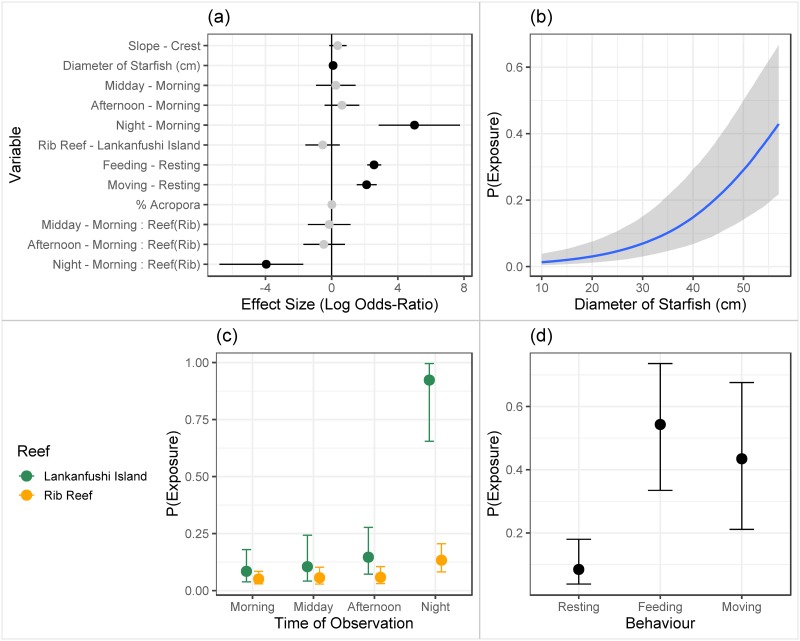
A) Effects plot showing the mean posterior effect size and 95% credible intervals (as log odds) of each predictor variable in the full model (Eqn 1). Black dots indicate variables with "significant" effects. B) Partial effect of diameter on the probability of exposure (P(exposure)). C) Partial effects of this interaction between observation time and reef location on P(exposure). D) Partial effect of behaviour on P(exposure).